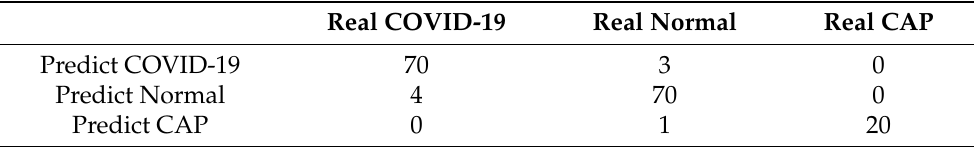
Table 13. Confusion matrix of SDViT on the X-ray Image dataset.